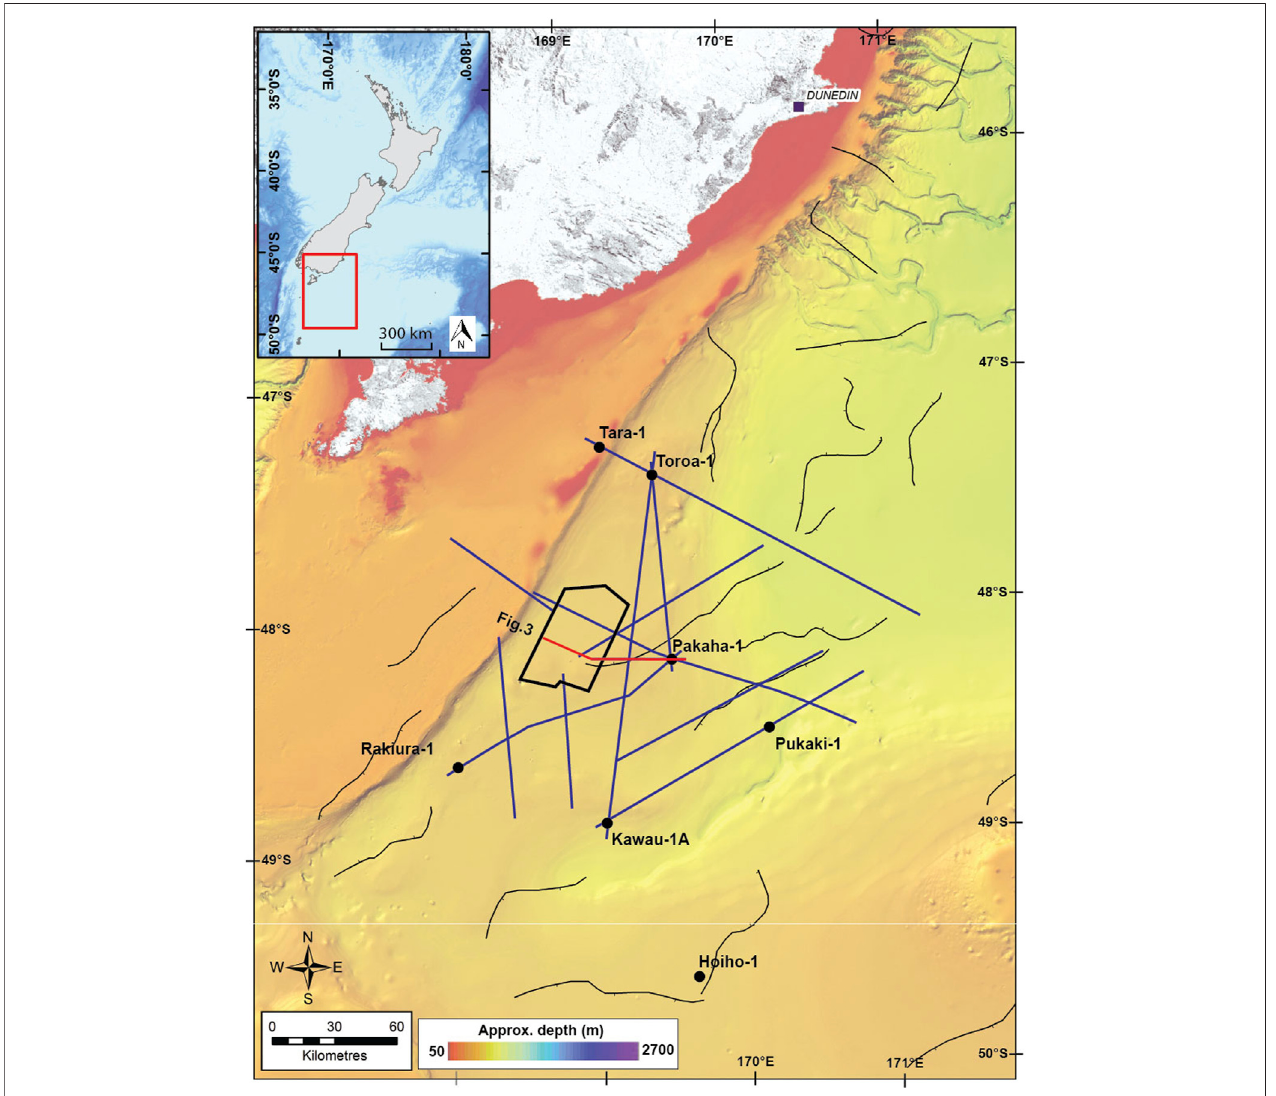
FIGURE2| LocationmapoftheGreatSouthBasinandstudyarea.TheGSB3Dseismicsurveyishighlightedasablackpolygon,andthetwo-dimensionalseismic linesarehighlightedasbluelines.Theredlinerepresentsaregionalseismicpro fi lein Figure3 .Thethinblacklinesrepresenttectonicfaultsinthebasin.Welllocationsare highlighted as black